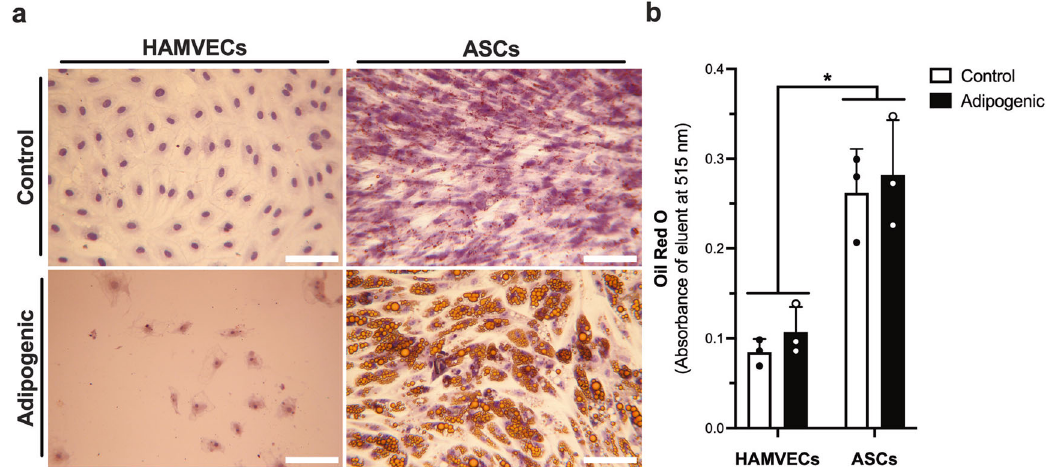
Fig. 3 Adipogenic plasticity is evident in adipose tissue-derived stromal/stem cells (ASCs), not human adipose tissue-derived microvascular endothelial cells (HAMVECs). HAMVECs and ASCs were cultured in adipogenic medium for 10 days before their accumulation of lipids was assessed by Oil Red O with hematoxylin counterstaining. Endothelial medium is used as control. Shown are representative photomicrographs depicting the accumulation of lipids by HAMVECs and ASCs ( a ), as well as a bar graph delineating its quanti fi cation ( b ). Hematoxylin stains nuclei blue/purple, and Oil Red O stains lipids red/orange. Scale bars represent 100 µ m. Values represent mean ± standard deviation; and * p < 0.05. Experiments were performed in biological triplicate, using cells derived from three different donors ( n = 3 biologically independent